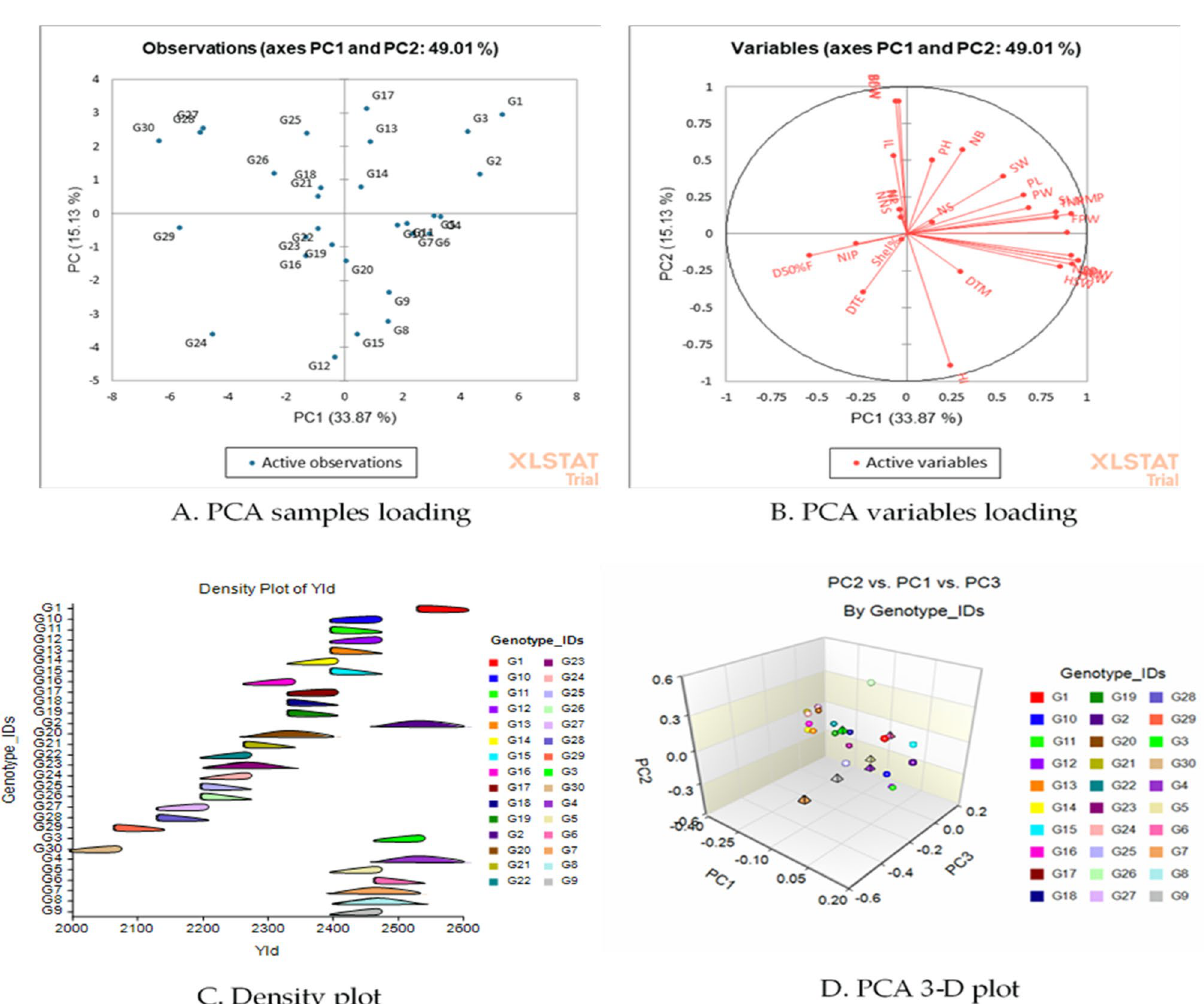
Figure 6. The PCA analysis depicts the ( A ) loading of samples (genotypes) and ( B ) loading of variables (traits) ( C ) density plot showing the genotypes distribution based on yield potential and ( D ) PCA 3D plot revealed by XLSTAT and NCSS